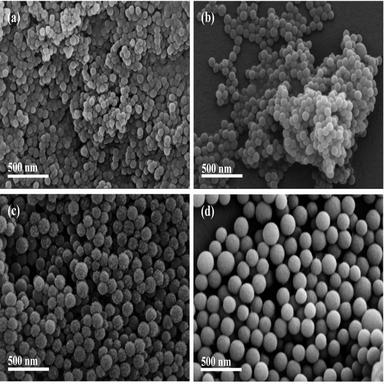
FESEM images of (a) D-mSiO2-45, (b) D-mSiO2-60, (c) D-mSiO2-75, (d) D-mSiO2-90 samples.